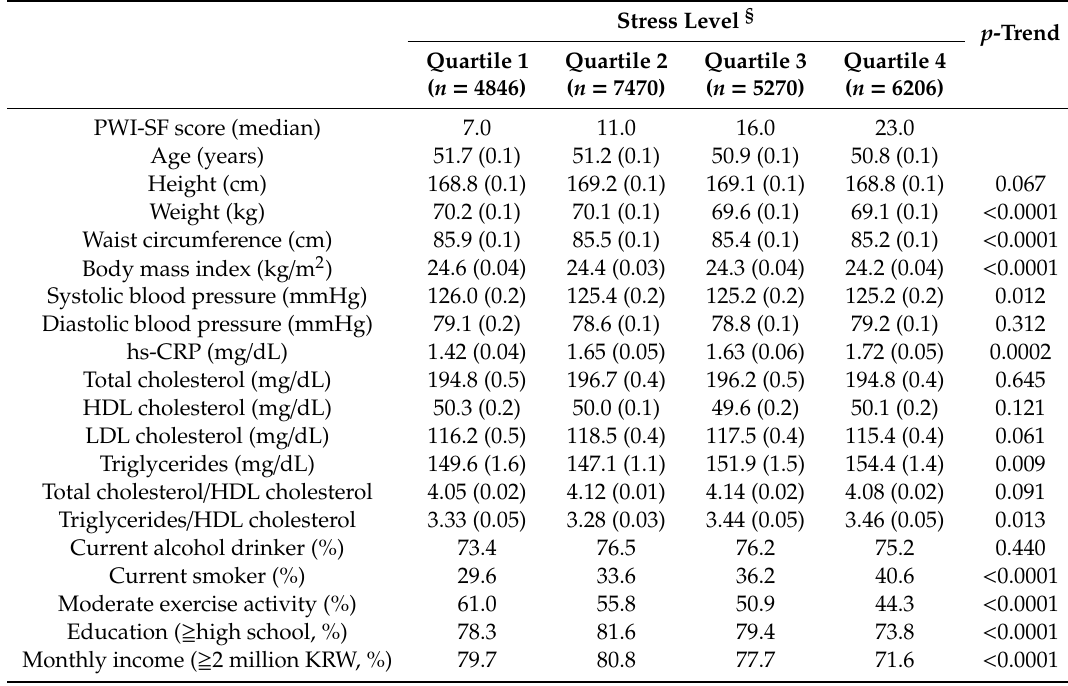
Table 1. General characteristics of the participants according to quartile of stress